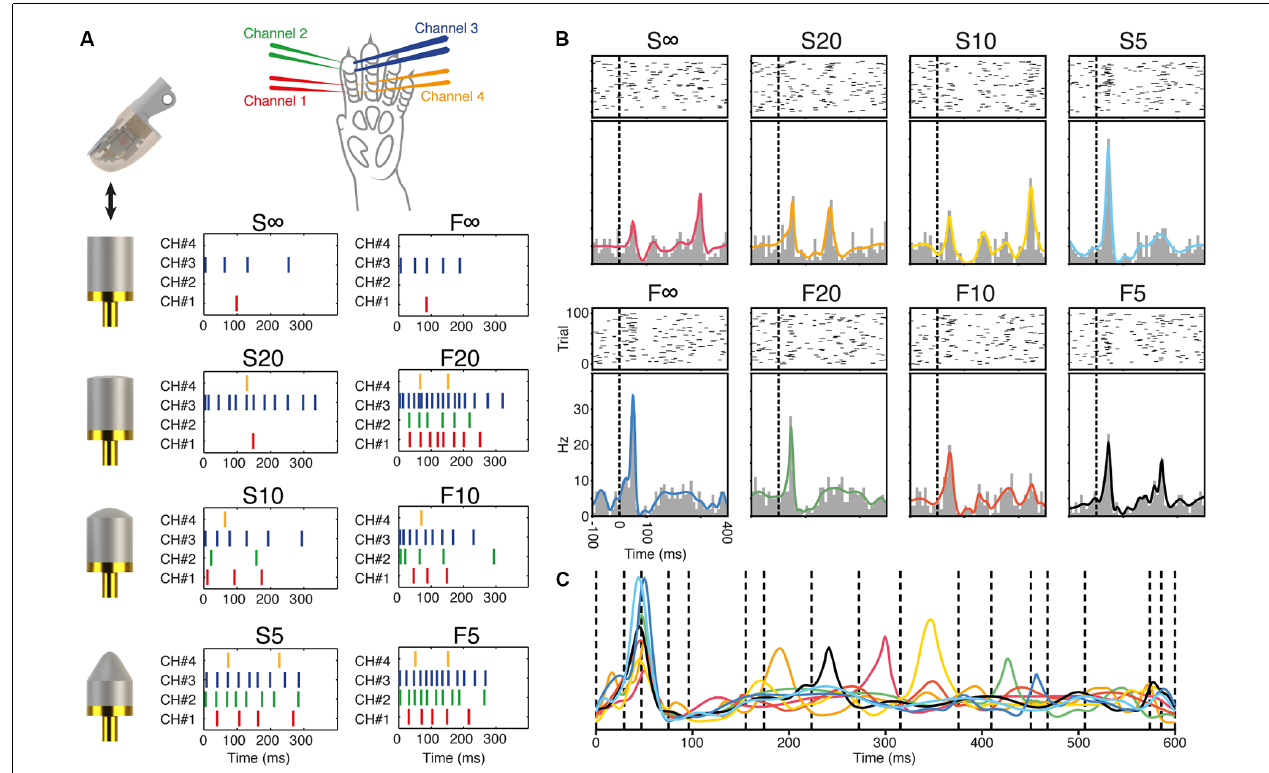
FIGURE 2 | Generation of the stimulation patterns and responses of a sample V1 neuron. (A) Illustration of the sensorized artificial fingertip and the objects it was dynamically moved against to generate the stimulation patterns. The figure also shows the location of the stimulation channels on the rat digit skin and the eight spatiotemporal stimulation patterns used to stimulate the digit skin. (B) Raster plots, peristimulus histograms and kernel density estimation (KDE) curves for the responses generated by the eight different stimulation patterns in a sample neuron recorded in V1 cortex. (C) The eight KDE response curves of the sample neuron are superimposed and shown together with the neuron-specific defined time windows used in the subsequent decoding